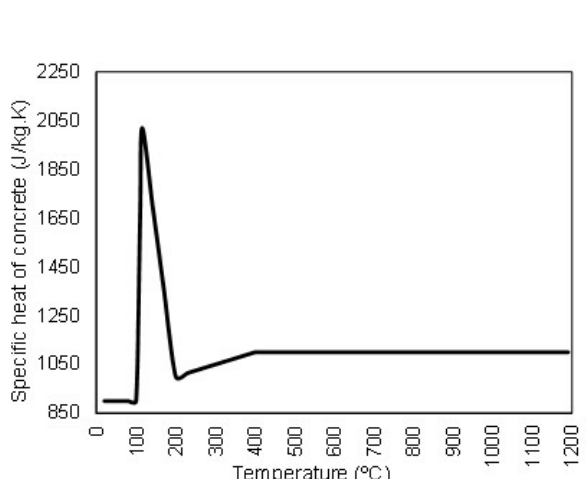
Figure A3 – Specific heat of